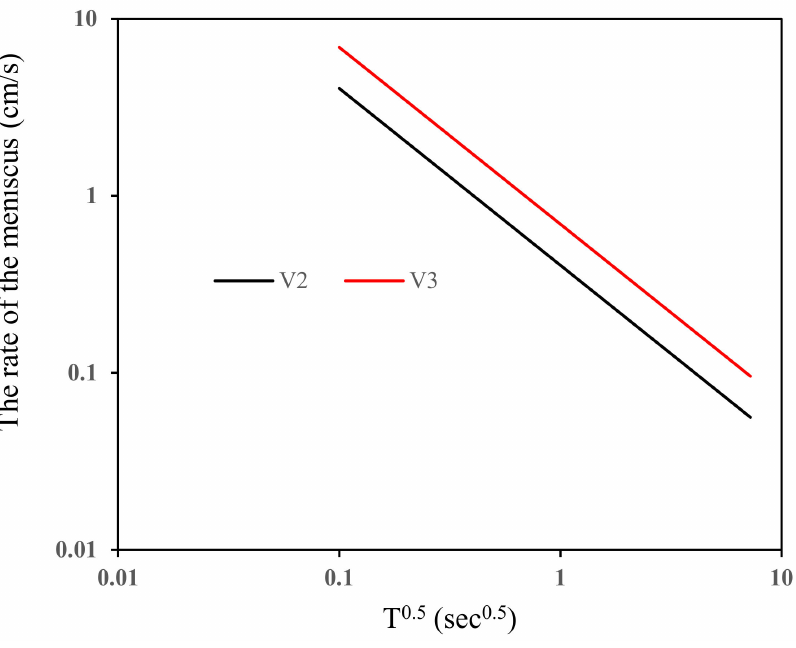
Figure 4. Variation of the advancing rate of two smaller capillaries.